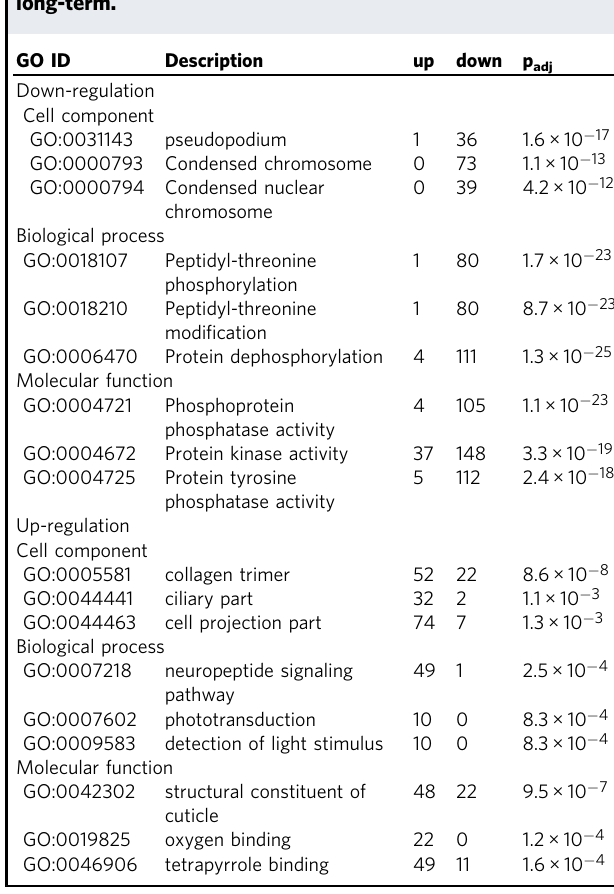
Table 2 The top-ranking GO terms in the GO enrichment of Caenorhabditis elegans fed PT-containing bacterial food,